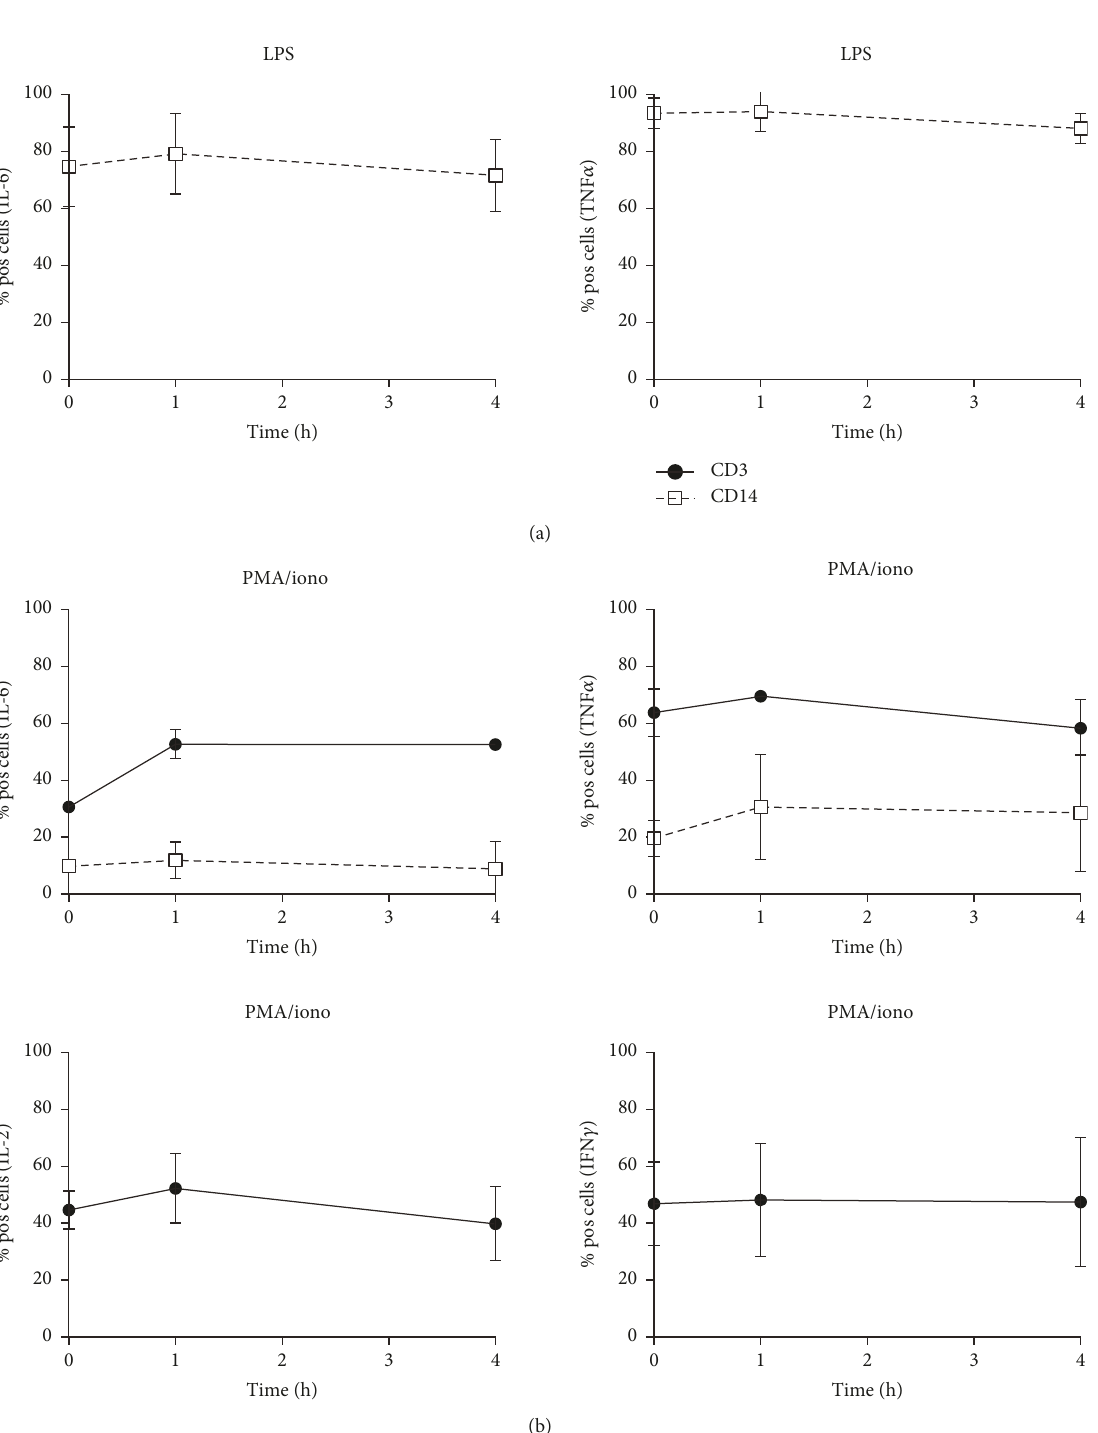
Figure 3: Cytokine-producing cells in whole blood cultures (average plus SD). The whole blood of 5 donors was stimulated for 3 hours with LPS (a) or PMA/ionomycin (b) in the presence of brefeldin A to block cytokine secretion. The percentage of positive cells for intracellular cytokines was quanti fi ed for T-cells (continuous lines) and monocytes (dashed lines). The x -axis indicates the sample age (time span between blood collection and start incubation). The blood was stored at room temperature. T-cells and monocytes remained negative for IFN γ staining after LPS